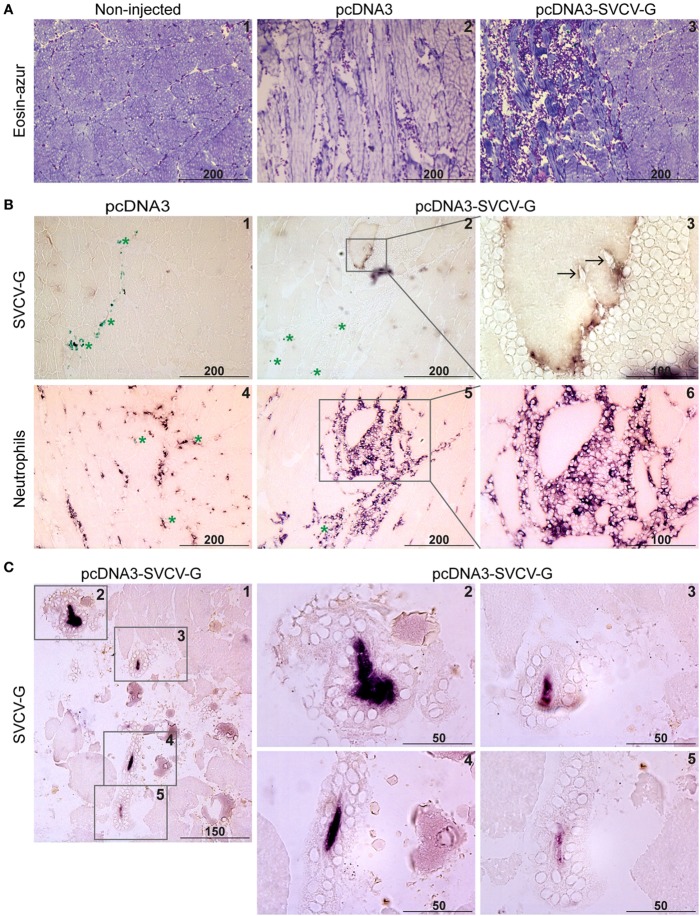
Immunohistochemical analysis of G-protein expression and leukocyte recruitment after DNA vaccination. Carp were injected with 20 µg of pcDNA3 or pcDNA3-spring viremia of carp virus (SVCV)-G. (A) Muscle was isolated at the site of injection at 7 days postinjection (dpi), and cryosections (5 µm) were stained with Hemacolor® (eosin-azur) to visualize leukocyte recruitment in non-injected (A.1), pcDNA3 injected (A.2), or pcDNA3-SVCV-G injected (A.3) tissue. (B) Muscle at the site of injection was isolated 7 dpi from carp injected with pcDNA3 (B.1) or pcDNA3-SVCV-G (B.2–3) and stained with anti-SVCV-G antibody (clone 13C10c). Green asterisks in panel (B.1) indicate ink particles along the needle path. Brown color in panel (B.2) indicates G-protein expression. Note that the G protein-expressing cell is detached from the rest of the tissue and surrounded by leukocytes. A magnification of panel (B.2) shows the G-protein reactivity [(B.3), purple/brown color] on the myocyte surface and the presence of leukocytes around and infiltrating (black arrows) the myocyte. A consecutive slide of the tissue at the same time point was stained using an antibody specific for carp neutrophilic granulocytes (B.4–6); the inset in panel (B.5) identifies the same G protein-expressing cell as in panels (B.2,B.3). (C) Muscle at the site of injection isolated 14 dpi was stained as described in panels (B.1–3); (C.1) overview of the muscle area in which four G protein-expressing myocytes could be detected; (C.2–5) higher magnification of the areas indicated by the insets in panel (C.1); note the condensation of the G-protein staining (purple color) and the presence of leukocytes surrounding the G protein-expressing myocytes. Scale bars indicate distance (in µm).